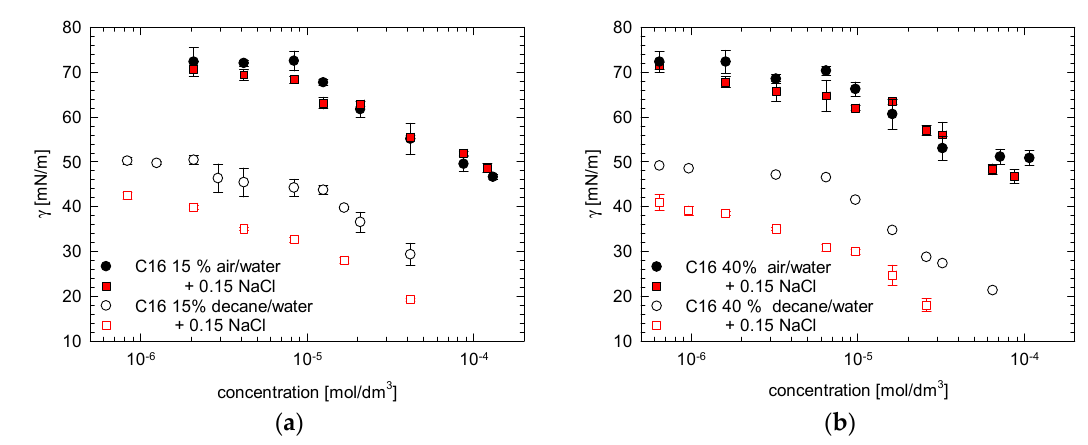
Figure 4. The dependence of the surface tension at air/solution and of interfacial tension at the decane/solution interface on copolymer molar concentration in water and 0.15 NaCl. ( a ) For PSS/MA-g-C 16 NH 2 (15%); ( b ) for PSS/MA-g-C 16 NH 2 (40%). Table 1. Mass of copolymer deposited on top of (PDADMAC/PSS) 4 PDADMAC multilayer film.